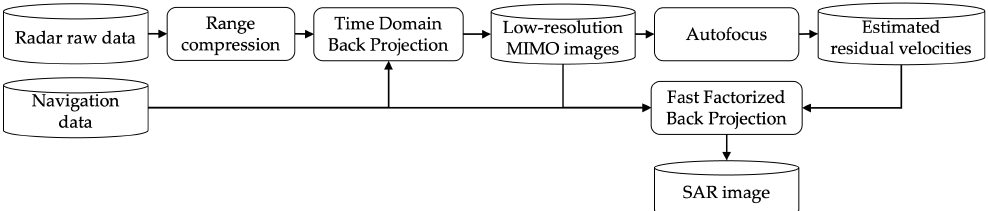
Figure 8. Block diagram of the complete workflow starting from the raw radar data to the final SAR